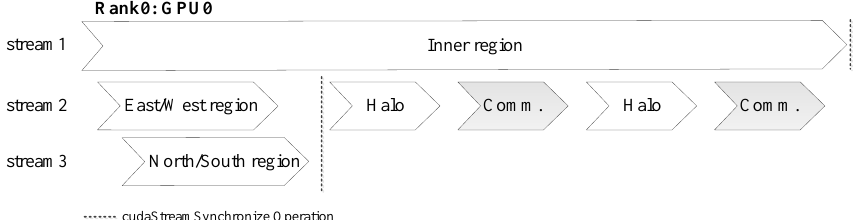
Figure 7. The workflow of multiple streams on the GPU. The Inner/East/West/North/South regions and Halo refer to the computation and update of the corresponding region. Comm. refers to the communication between processes, which implies